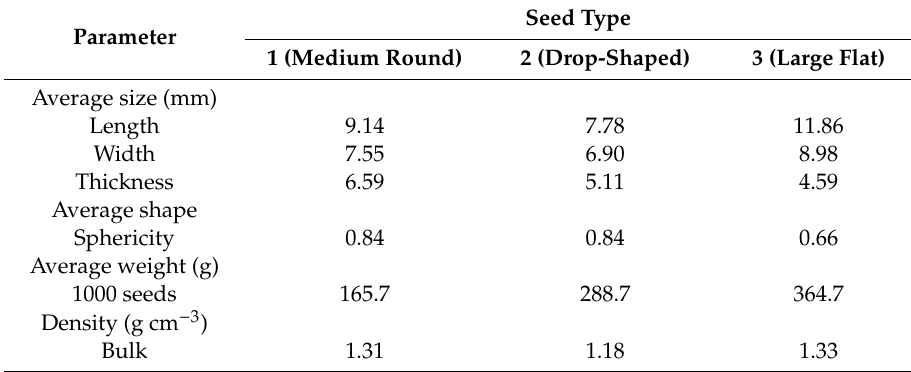
Table 2. Characterization of maize seed